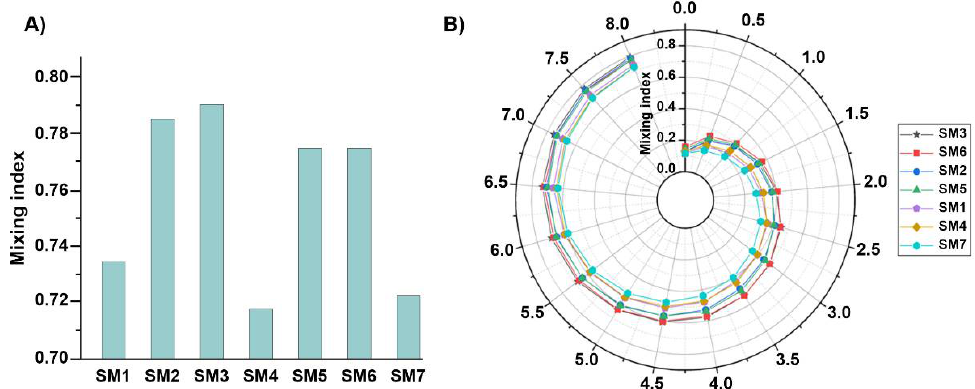
Figure 3. Evaluation of the mixing performance at Re = 5 for the proposed micromixers based on ( A ) final and ( B ) along-the-loop mixing index. The impact of height ratios on mixing quality is more significant than the outward/inward position of the shorter wall.